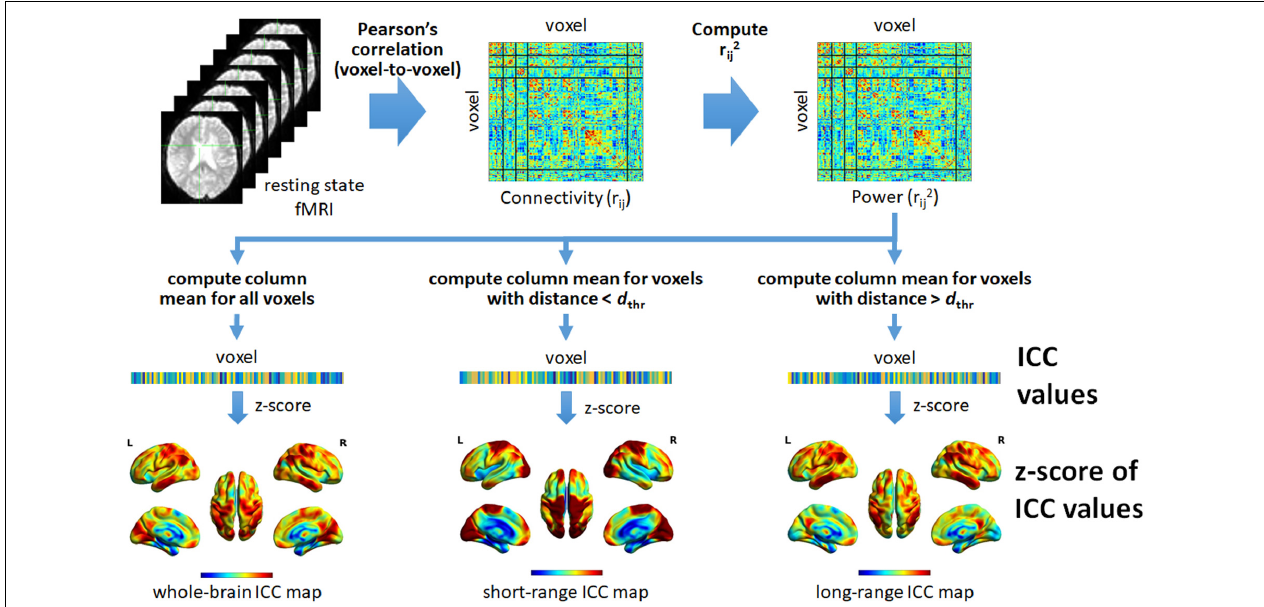
FIGURE 1 | Schematic illustration of the different steps to compute the intrinsic connectivity contrast (ICC) values from resting state fMRI data. Using the preprocessed data, we computed Pearson’s correlation ( r ij ) between pairs of voxels within the brain resulting in a whole-brain connectivity matrix quantifying voxel-to-voxel connectivity. The square of the value of each element in the connectivity matrix was then computed in order to obtain the form of the ICC that computes the power ( r ij 2 ). The resulting squared connectivity matrix or “power” matrix was then used to generate the whole-brain, short-range, and long-range ICC maps. For the whole-brain ICC map, the column-wise mean of the power matrix was computed (excluding self-connection). The resulting mean values were then converted to z-scores to form the map. For the short-range ICC map, only voxels with (Euclidean) distance less than a given threshold, denoted as d thr , relative to the reference voxel (voxel i for column i ) were included in computing the mean values. On the other hand, for the long-range ICC map, only voxels with distance greater than d thr were included. For both, the computed mean values were also converted to z-scores to form the corresponding maps. L, left; R,